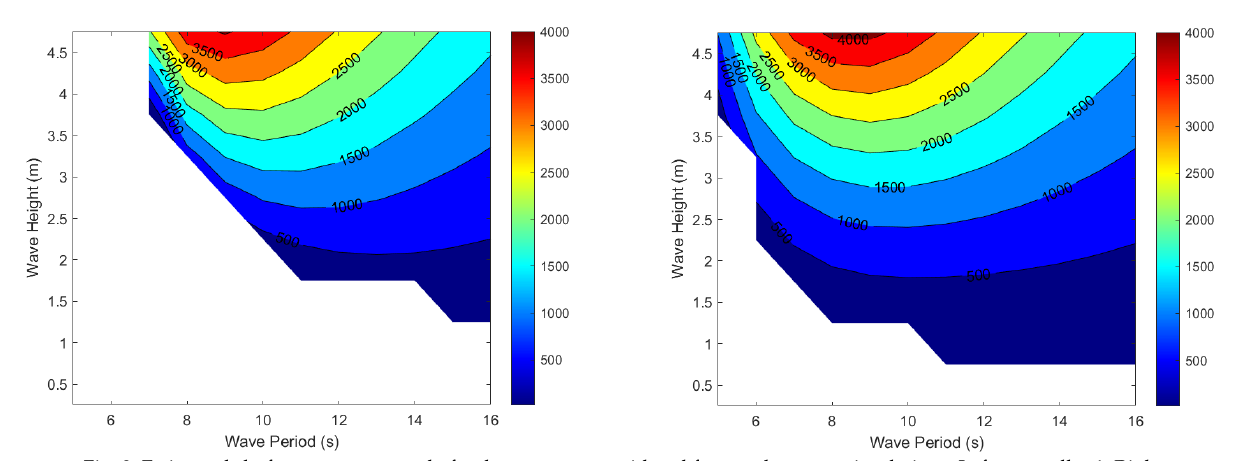
Fig. 9: Estimated shaft power generated after losses were considered for regular wave simulations. Left, controller 1. Right, controller 2. Units in